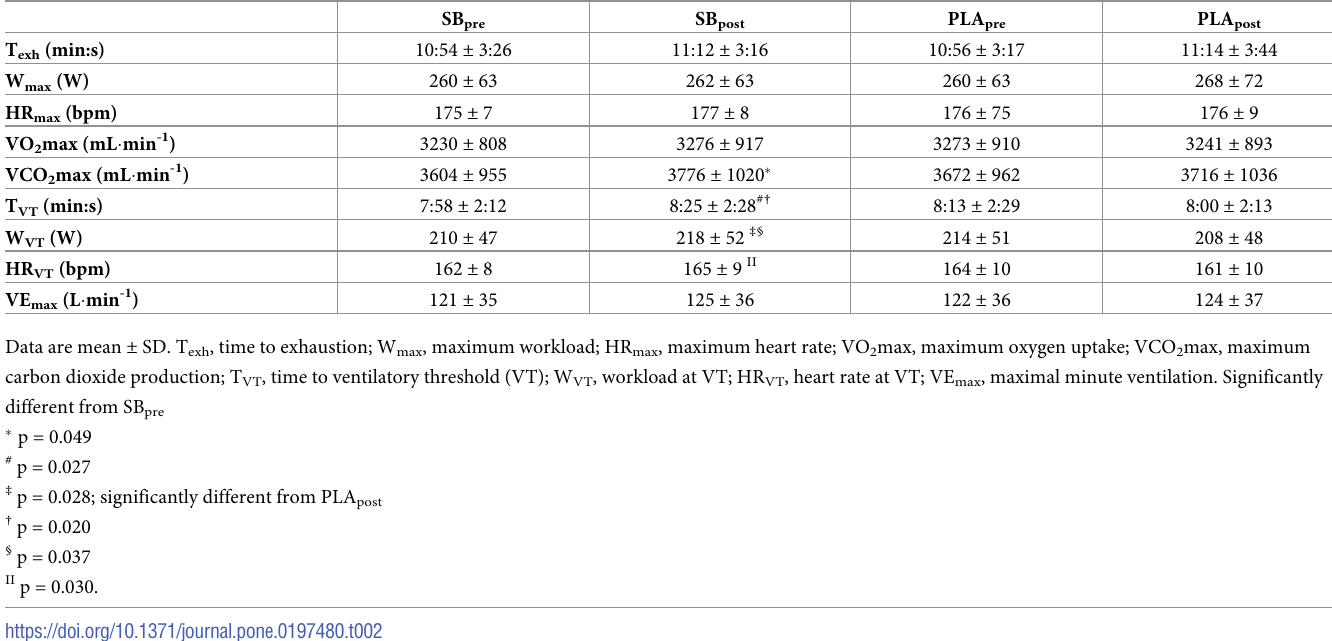
Table 2. Performance and ventilatory threshold in incremental cycling test